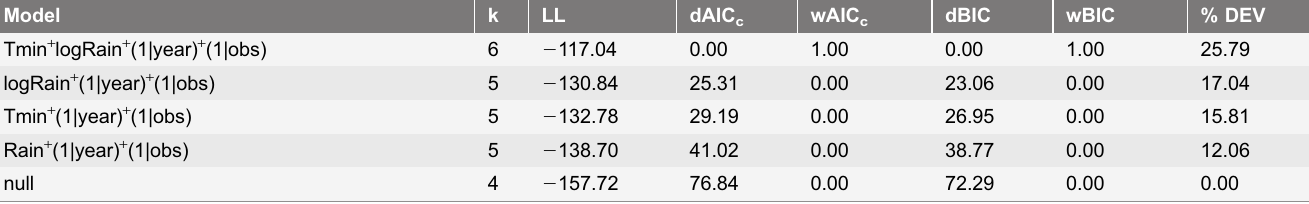
Table 1. Correlates of RCV-A1 prevalence in wild rabbit populations in Australia.